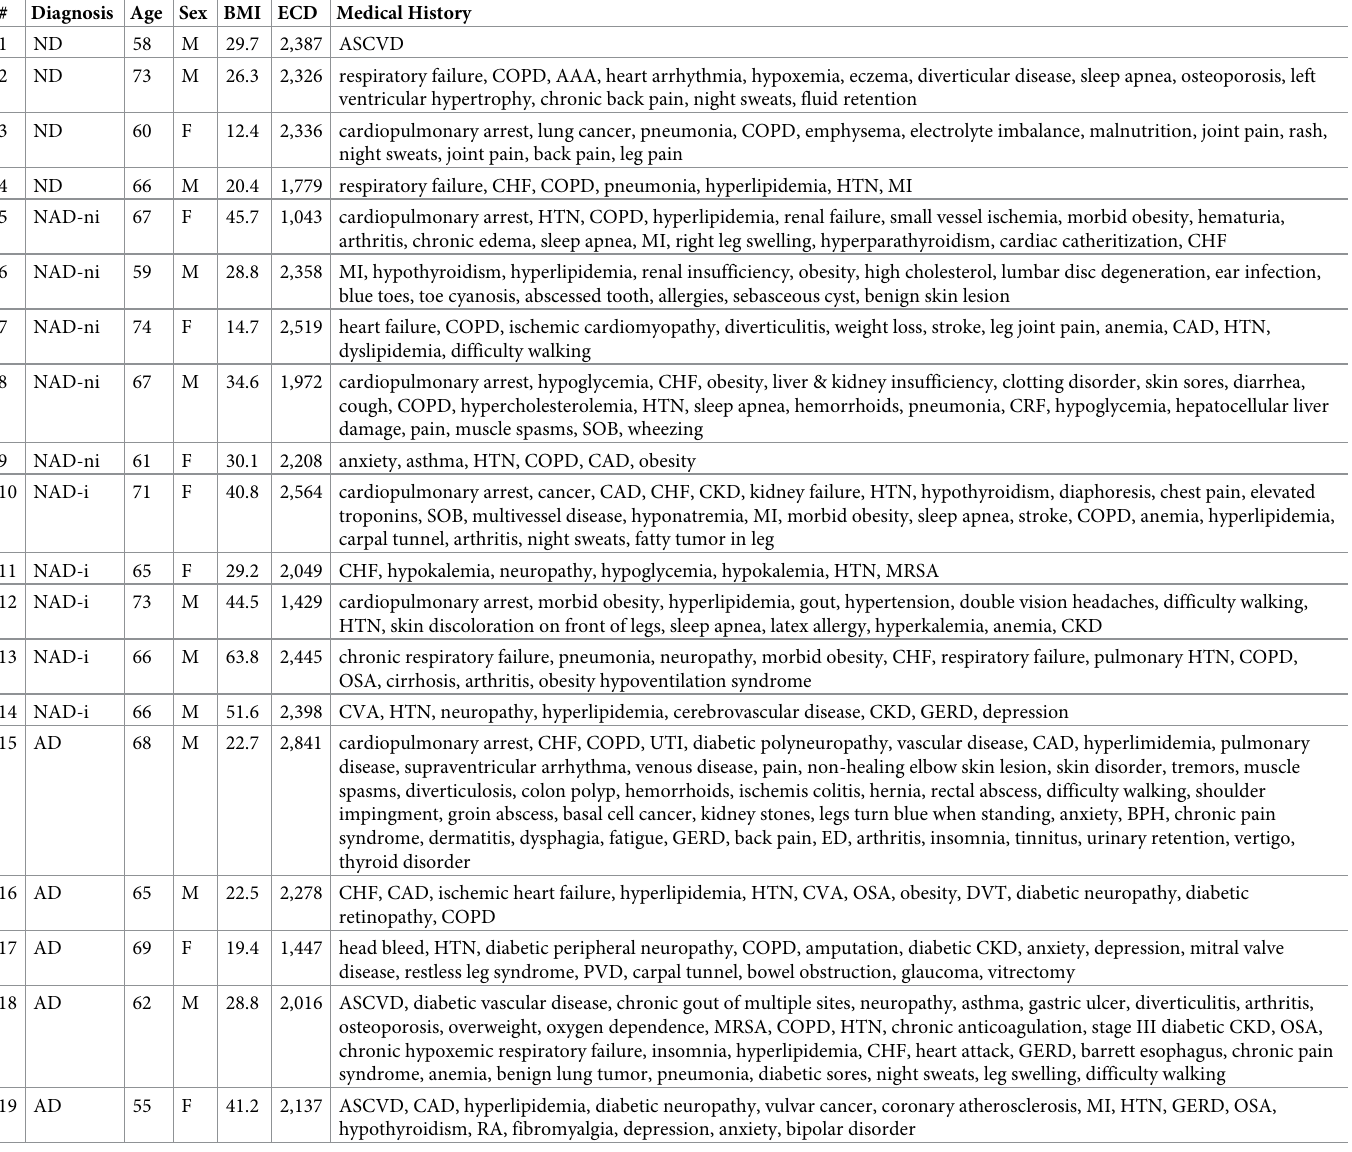
Table 1. Donor EDM sample